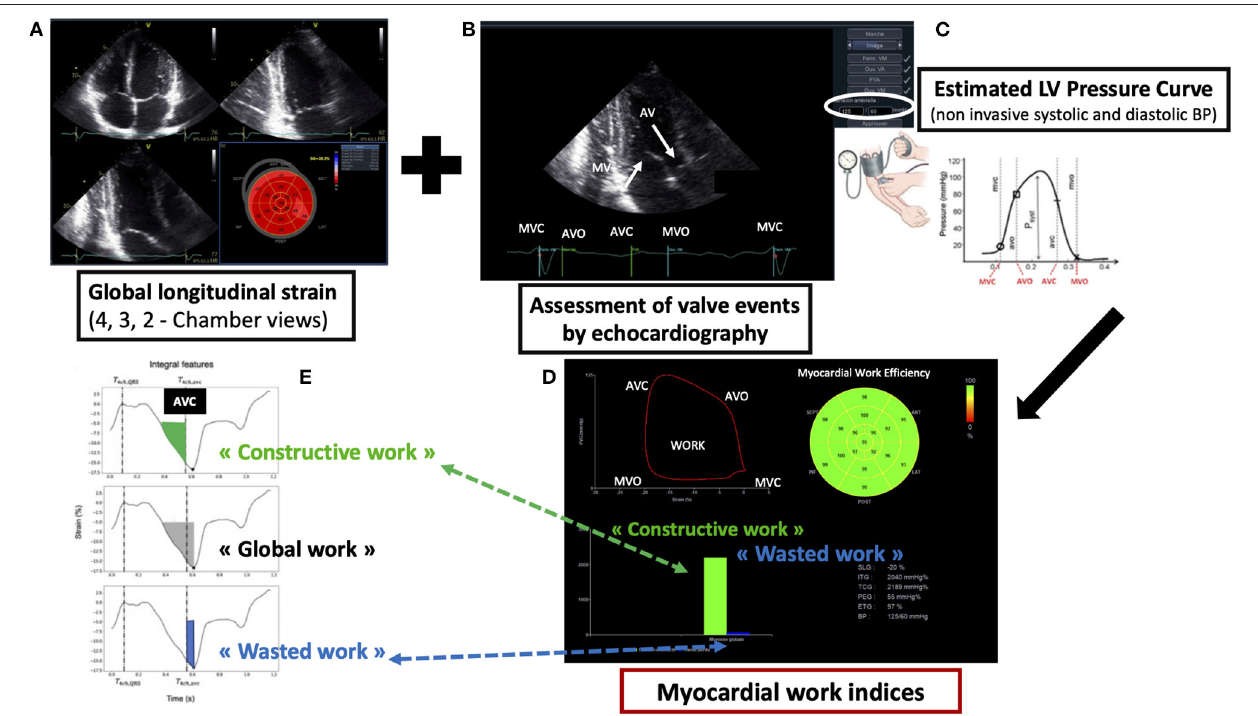
FIGURE 2 | Methodology of myocardial work (MW) assessment. (A) Acquisition of apical four-, two-, and three-chamber view and evaluation of global longitudinal strain (GLS) with left ventricular (LV) bull’s eye. (B) Assessment of valve events by echocardiography (MVC, mitral valve closure; AVO, aortic valve opening; AVC, aortic valve closure; MVO, mitral valve opening). (C) Introduction of systolic and diastolic blood pressure; peak systolic LV pressure is assumed equal to the peak arterial pressure recorded from the brachial cuff systolic pressure. A patient-specific LV pressure curve is constructed by the software, adjusting LV pressure curve to the duration of the isovolumic and ejection phases, defined by valvular timing events. Strain and pressure data are synchronized using the R wave on ECG as common time reference. (D) Evaluation of global values of all myocardial work (MW) components; bars showing the constructive (green bar) and wasted (blue bar) global work. (E) During the isovolumic contraction and LV ejection period, segmental shortening contributes to the final LV ejection, whereas segmental stretch or lengthening does not contribute to LV ejection. As a result, the work performed by the myocardium during segmental shortening represents constructive work (CW), whereas the work performed by the myocardium during stretch or segmental lengthening represents energy loss, defined as wasted work (WW).